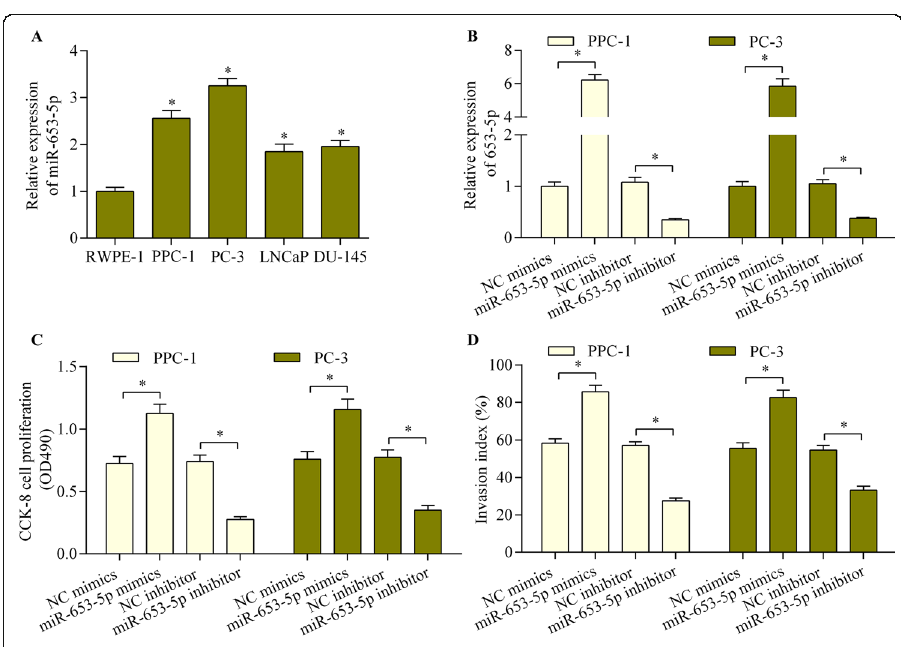
Fig. 4 MiR-653-5p inhibition repressed prostate cancer cell proliferation and invasion. a The relative miR- 653-5p expression in prostate cancer cell lines was examined using quantitative real-time PCR ( n = 5, * p < 0.05 versus RWPE-1). b PPC-1 and PC-3 cells were transfected with miR-653-5p mimics, inhibitor or NC mimics/inhibitor for 48 h. The relative miR-653-5p expression was determined using quantitative real-time PCR. c Cell proliferation was measured with the CCK-8 assay after transfection with miR-653-5p mimics, inhibitor or NC mimics/inhibitor for 48 h. d PPC-1 and PC-3 cells were transfected with miR-653-5p mimics, inhibitor, or NC mimics/inhibitor for 48 h. The transwell Matrigel invasion assay to determine cell invasion ran for 24 h ( n = 5, * p <